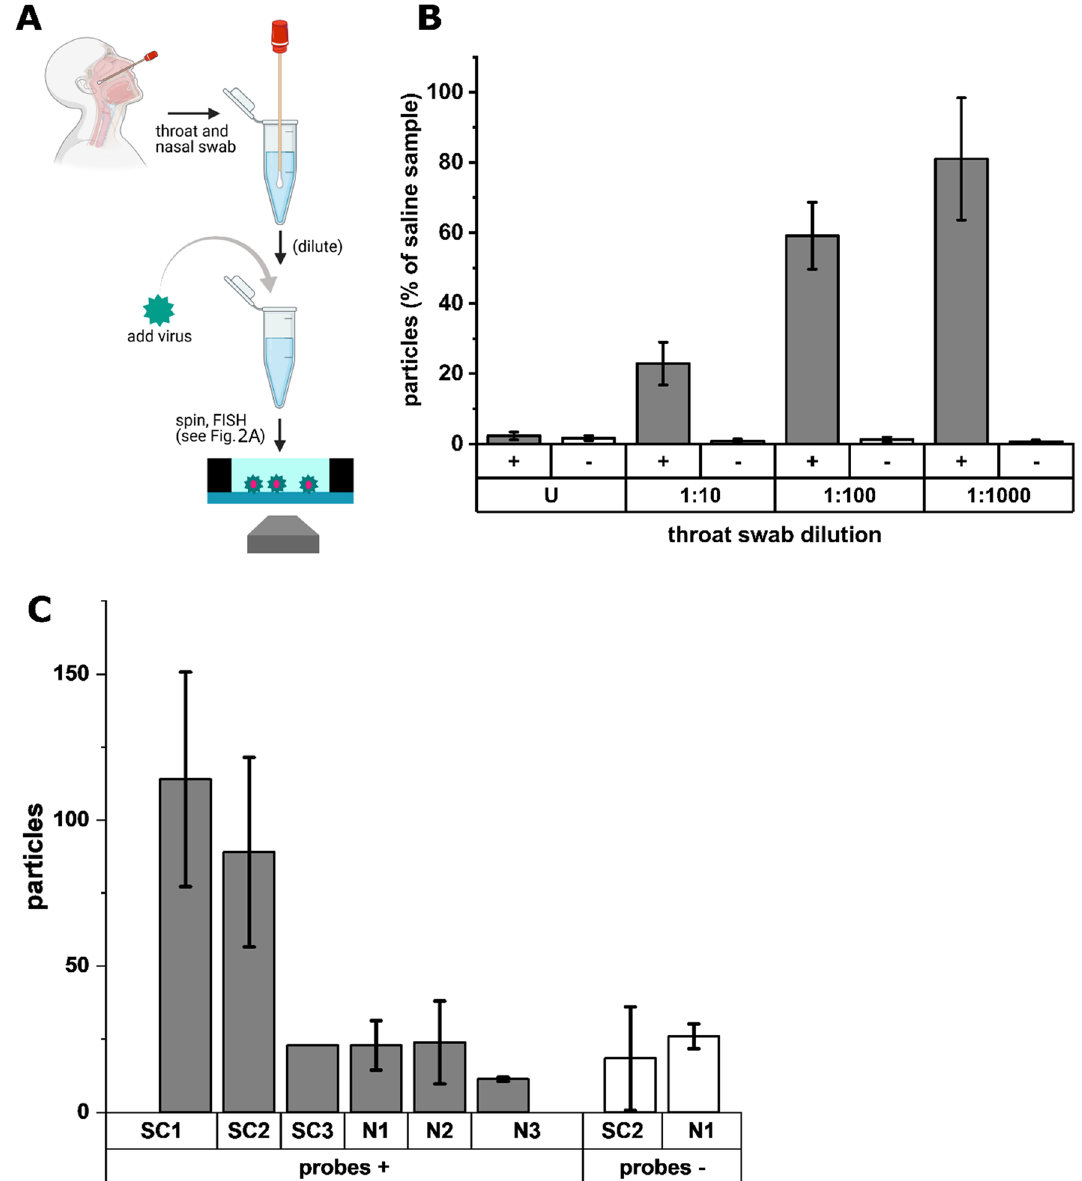
Figure 6. Efficiency of virus detection in a throat swab. ( A ) Combined nasal and throat swabs were taken according to WHO instructions 42 . Subsequently, the throat swabs were diluted in saline and spiked with the same concentration of IBV (10 4 PFU/mL) in each sample. After a centrifugation step, virus particles were immobilized and FISH stained as described. ( B ) Efficiency of virus detection in throat swabs compared to virus diluted with saline, dependent on the dilution factor. [+]: IBV probes, [–]: SARS-CoV-2 probes, U: undiluted, error bars: SD of three independent experiments. ( C ) Mean particle counts of clinical samples analyzed by rvFISH using complementary (grey bars, ‘probes + ’) and non-complementary (white bars, ‘probes –’) probes. SC1–3: SARS-CoV-2 positive samples. N1–3: SARS-CoV-2 negative clinical samples. Error bars: standard deviation of two independent